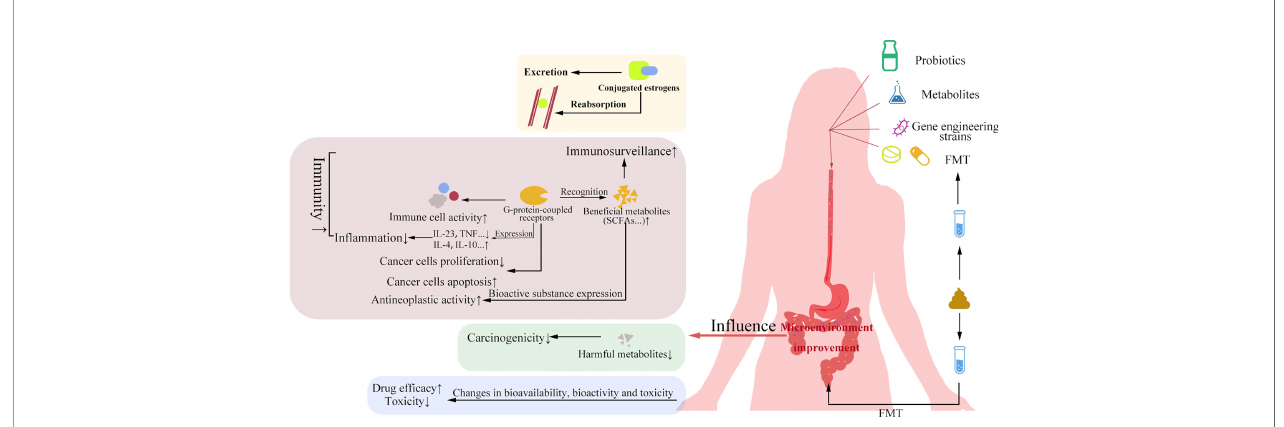
FIGURE 2 | Signi fi cance of probiotics and FMT in gynecological cancers. Probiotics and their metabolites, genetic engineering strains and FMT can improve the gut microbial environment. The improvement of gut microbial environment can affect estrogen level, improve cancer immunity and chemotherapy ef fi cacy, increase apoptosis of cancer cells, and reduce the rapid proliferation of cancer cells and drug side